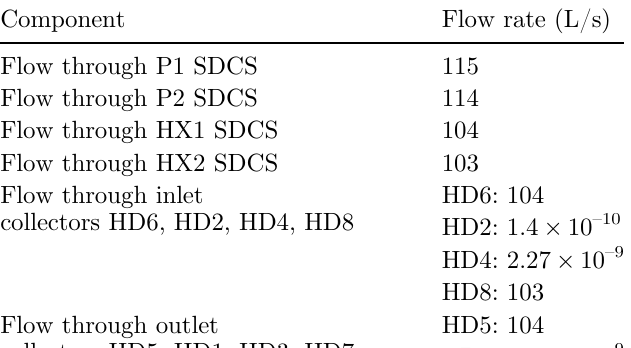
Table 2. Hydraulic analysis. Model I.